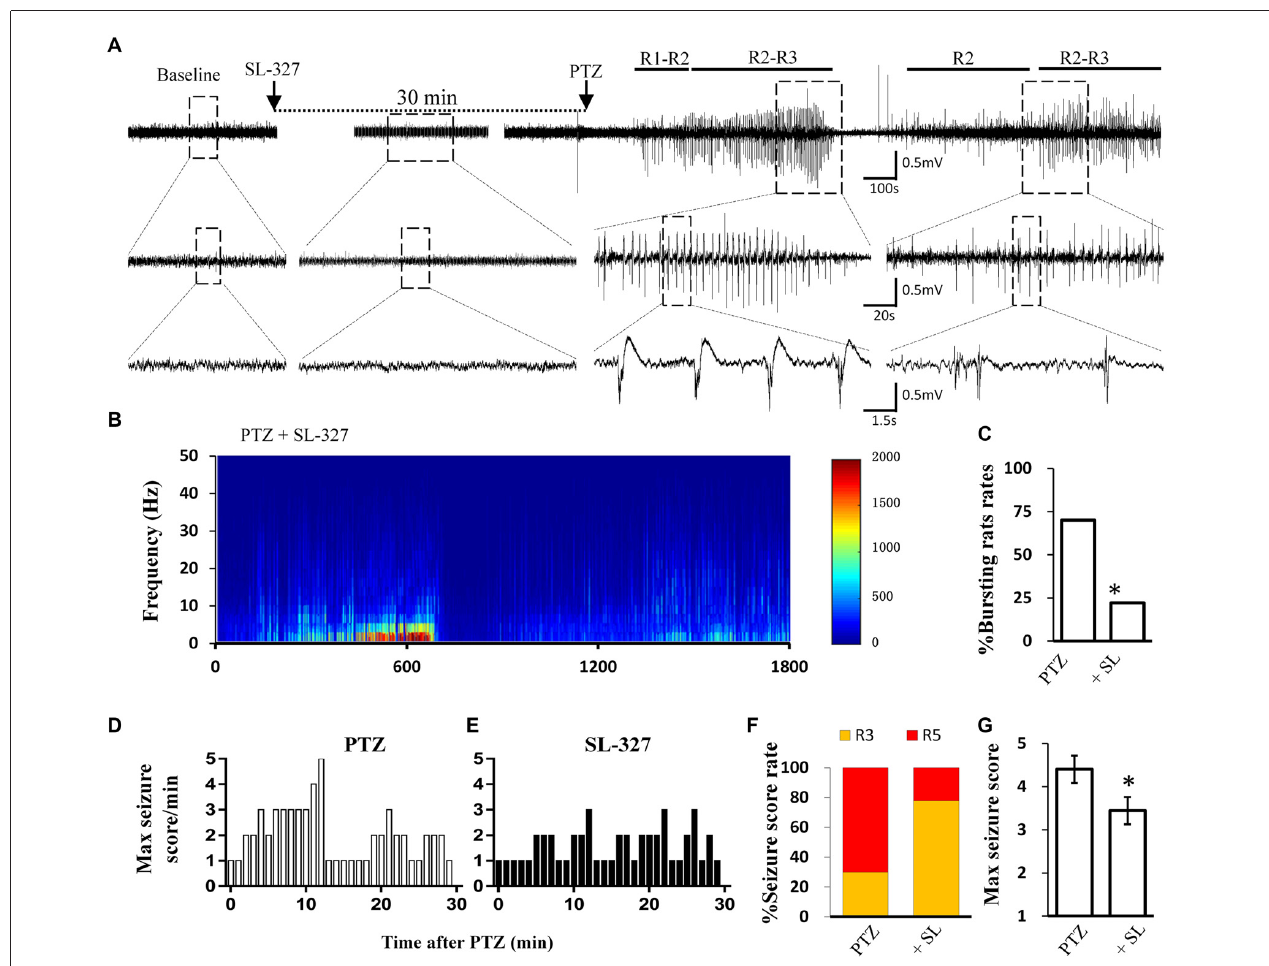
FIGURE 5 | SL-327 intervention improved the incoming seizure induced by PTZ in freely moving rats . (A) Typical EEG recording traces from SL-327 pre-treated rats. The lower traces are an enlarged drawing from the dashed boxes of upper traces. (B) EEG power from the recording of above trace was plotted against time, from PTZ administration to the following 30 min. The intensity of high frequency firing has been increasing in the first 10 min, but never reached to HAFDs during 30 min analysis in comparison with PTZ control rat described in Figure 1A . (C) Rate of animal with bursts and HAFDs from the two treating groups. (D,E) The static behavioral seizure scores over the 30 min period from the PTZ alone and PTZ + SL-327 groups illustrated in panel. (F) Proportion of rats with different seizure score. R3 and R5 represent the seizure score of Racine3 and Racine5, respectively. (G) The average of the maximal behavior scores for rats from either PTZ or SL-327 group. ∗ p < 0.05 compared with PTZ